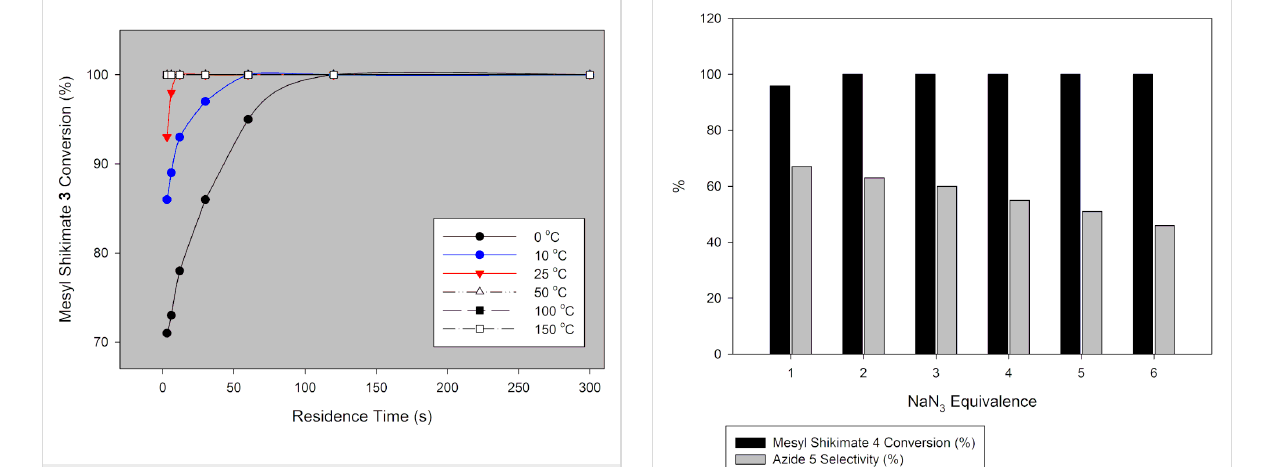
Figure 3: Mesyl shikimate azidation conversion in a continuous-flow system using NaN 3 .